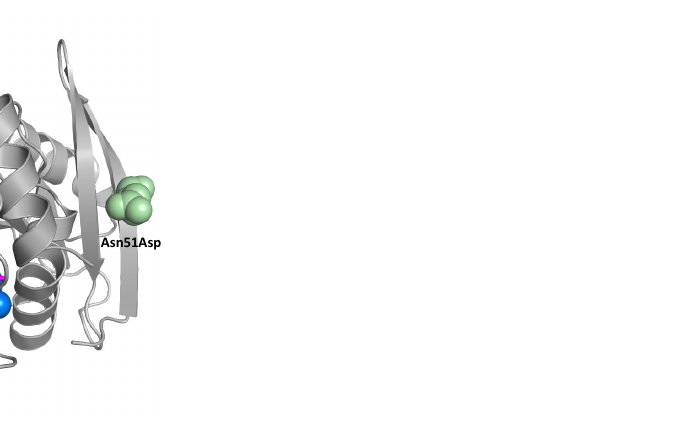
Figure 2. Cartoon backbone representation of the hydrolase structure. Pink: chloramphenicol; orange: amino acids involved in Cm binding and cleavage according to [33]; blue: mutations near the active center; green: further mutations. The figure was generated using Pymol [34].